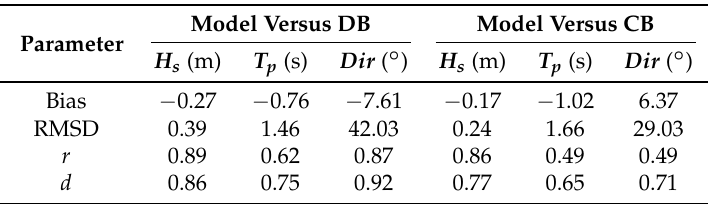
Table 2. Statistical comparison between the model results and DB and CB data of significant